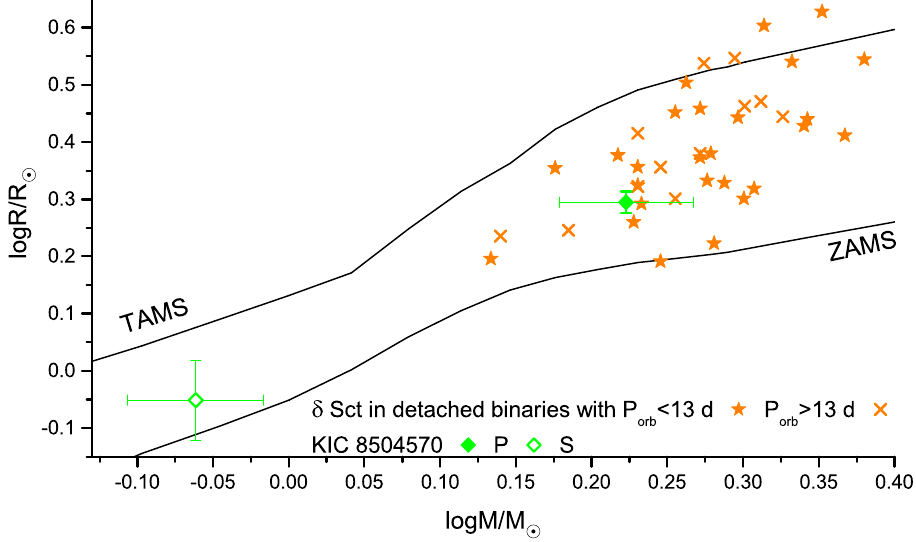
Figure 8. Locations of the primary (filled symbol) and secondary (empty symbol) components of KIC 8504570 (diamonds) within the mass-radius diagram. The stars and the “ × ” symbols denote the δ Scuti components of other detached systems with P orb shorter and longer than 13 d, respectively (taken from Liakos and Niarchos [26] and Liakos [32]). The black solid lines represent the main-sequence edges.